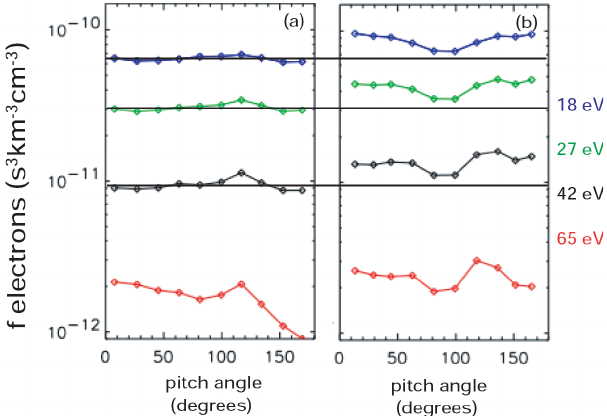
Fig. 5. Electron pitch angle distributions for EESA-L energy channels 18, 27, 42, and 65eV (a) in the ambient solar wind at 01:45:00UT, and (b) inside the outflow region at